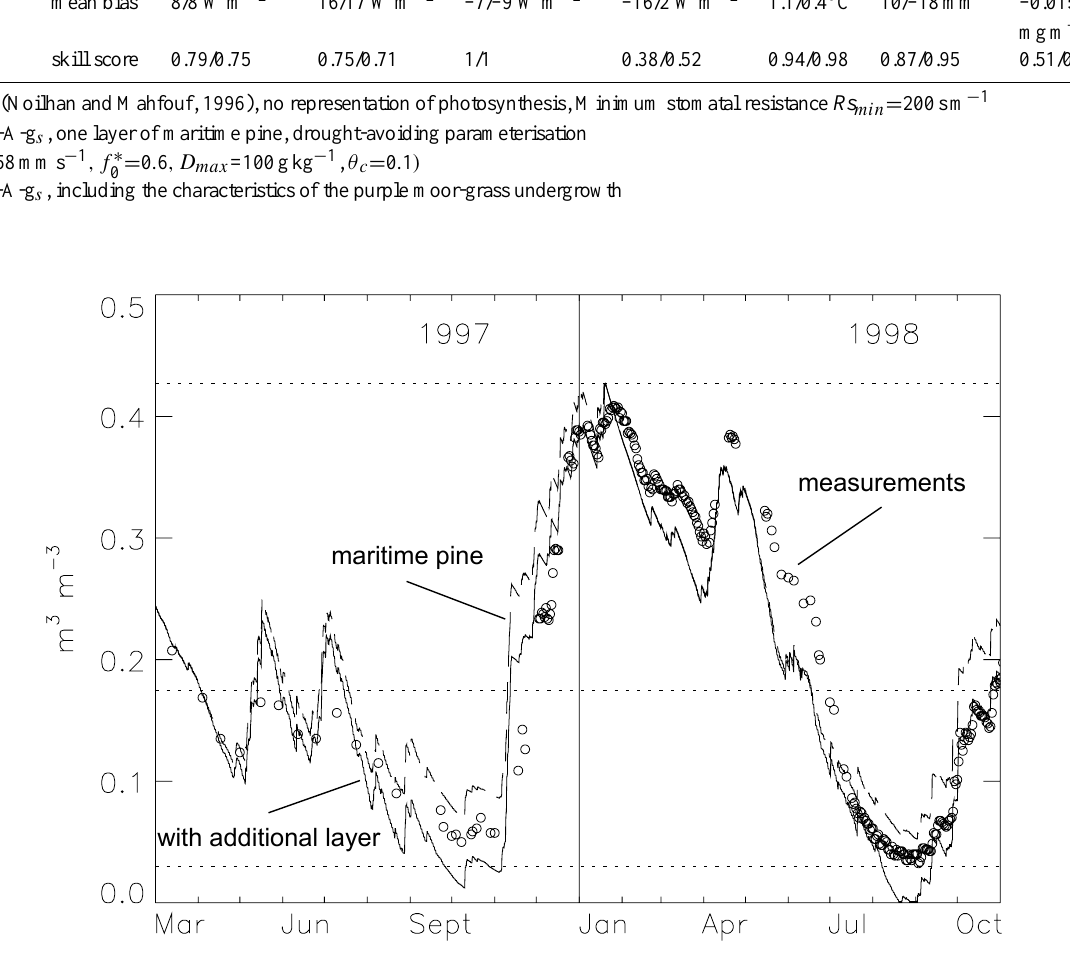
Fig. 3. Comparison of the ISBA-A-g s simulations of soil moisture with the measurements (lines and circles, respectively), in 1997 and 1998, for Le-Bray. Two simulations are compared: considering a single layer of maritime pine, or a layer of maritime pine and an additional layer representing the purple moor-grass undergrowth (long-dashed and solid lines, respectively). The dashed lines indicate (from top to bottom) different soil water contents: saturation, field capacity, wilting point. Soil moisture measurements concern the 0.8m soil